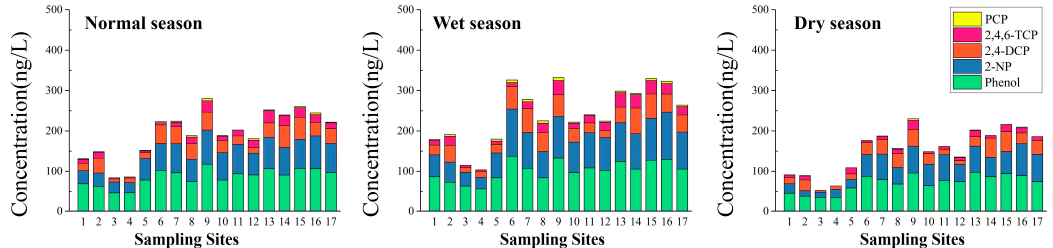
Figure 2. Spatial and seasonal distributions of the concentrations of five phenolic compounds in water from different sampling sites of the Yinma River Basin. PCP: pentachlorophenol; 2,4,6-TCP: 2,4,6-trichlorophenol; 2-NP: 2-nitrophenol; 2,4-DCP: 2,4-dichlorophenol.